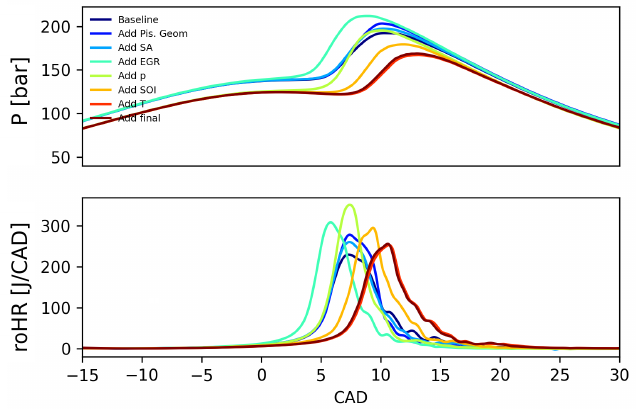
Figure 23. Influence of different parameters on pressure and heat release rate